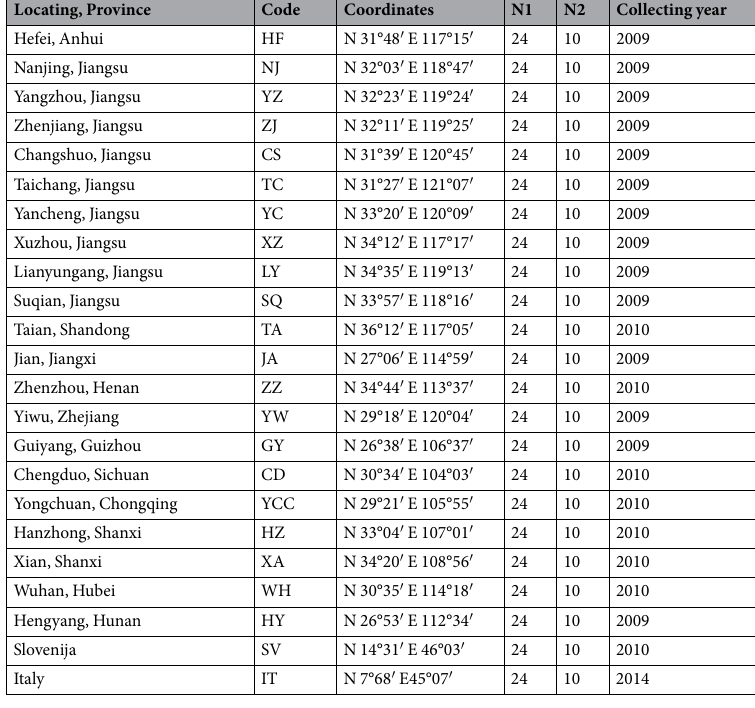
Table 8. The information of sampling populations. N1, the number of individuals genotyped at nine microsatellites; N2, the number of partial MtDNA genes ( COI , ND1 and ND5 ) sequences